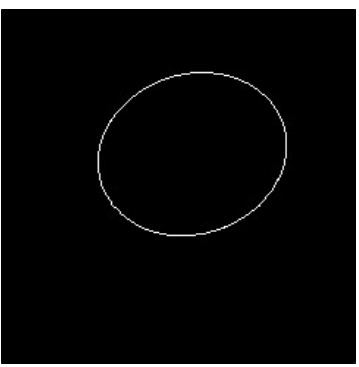
Figure 41. Fitting pupil elliptical image.